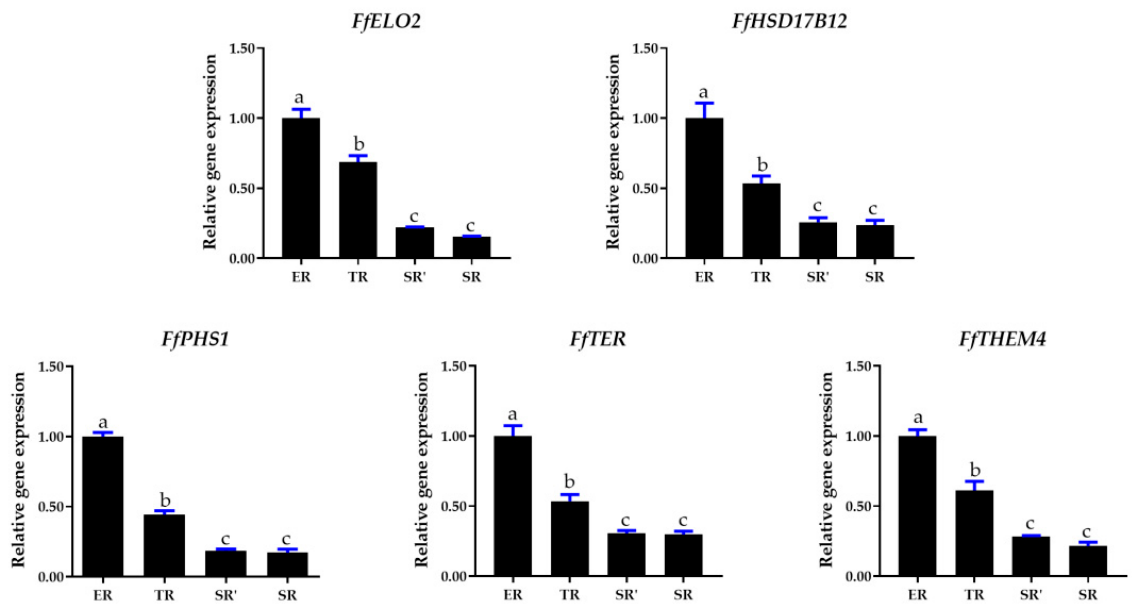
Figure 11. Expression of long-chain fatty acid synthesis of fatty acid elongation pathway (PATH: map00062, Module: M00415) genes in elongation region (ER), transition region (TR), and two stable regions (SR’ and SR). Letters over columns denote significant differences ( p < 0.05, n = 4, paired t